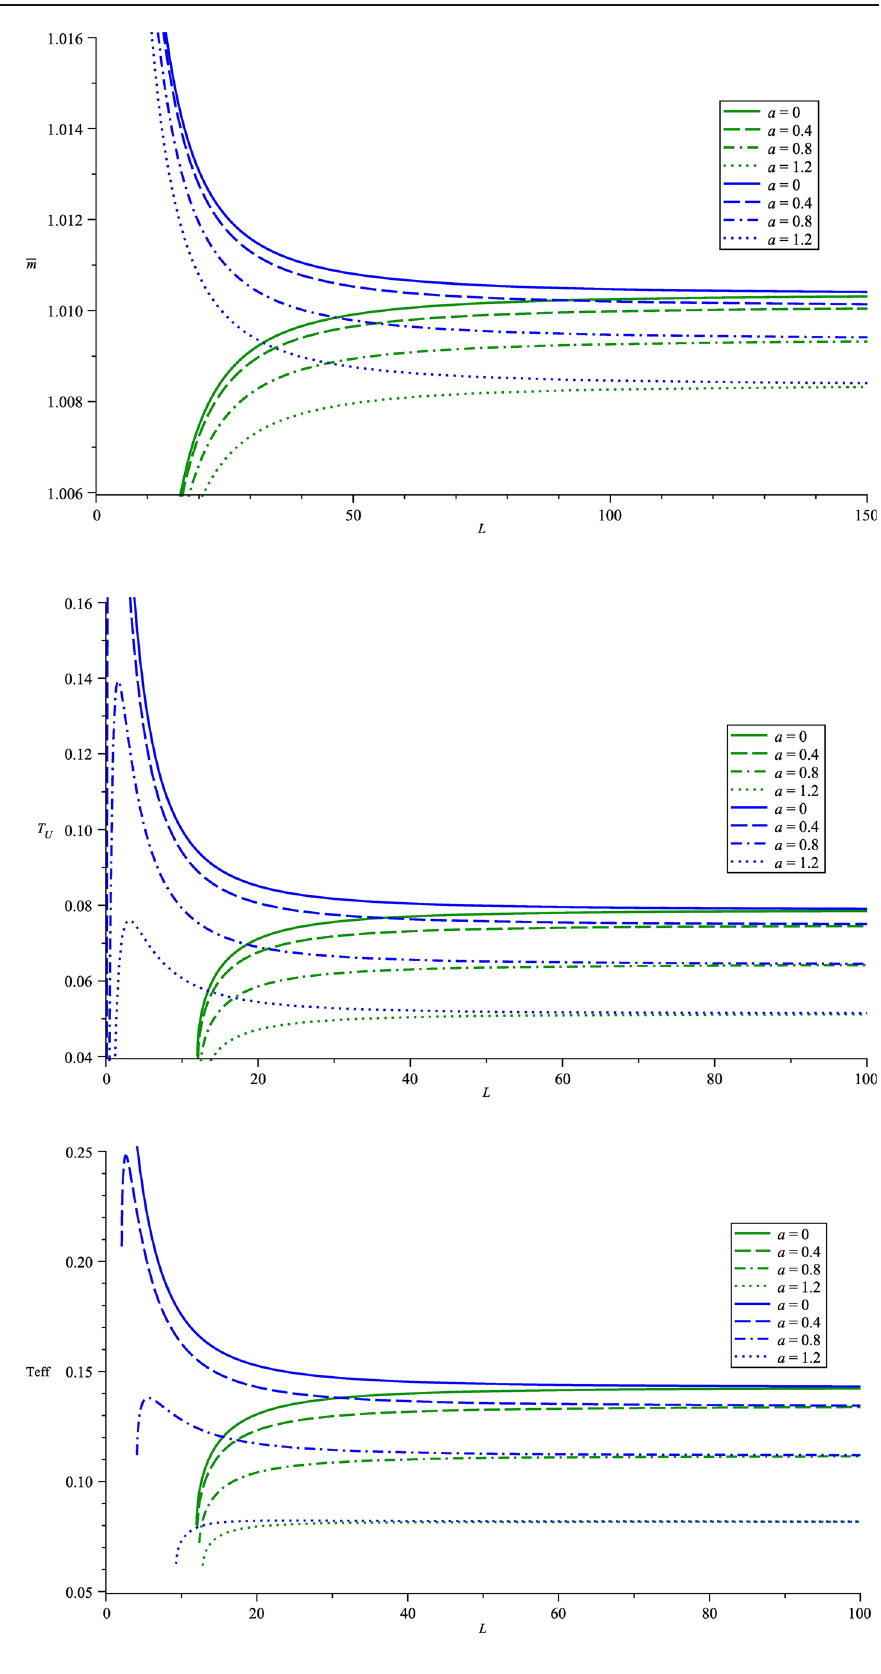
Fig. 6 Inertial mass ¯ m in AdS (blue) and dS (green) with parameters Q 2 + P 2 = 12 , qQ + pP = 6 , m = 1 ,λ l = 0 , n = 0